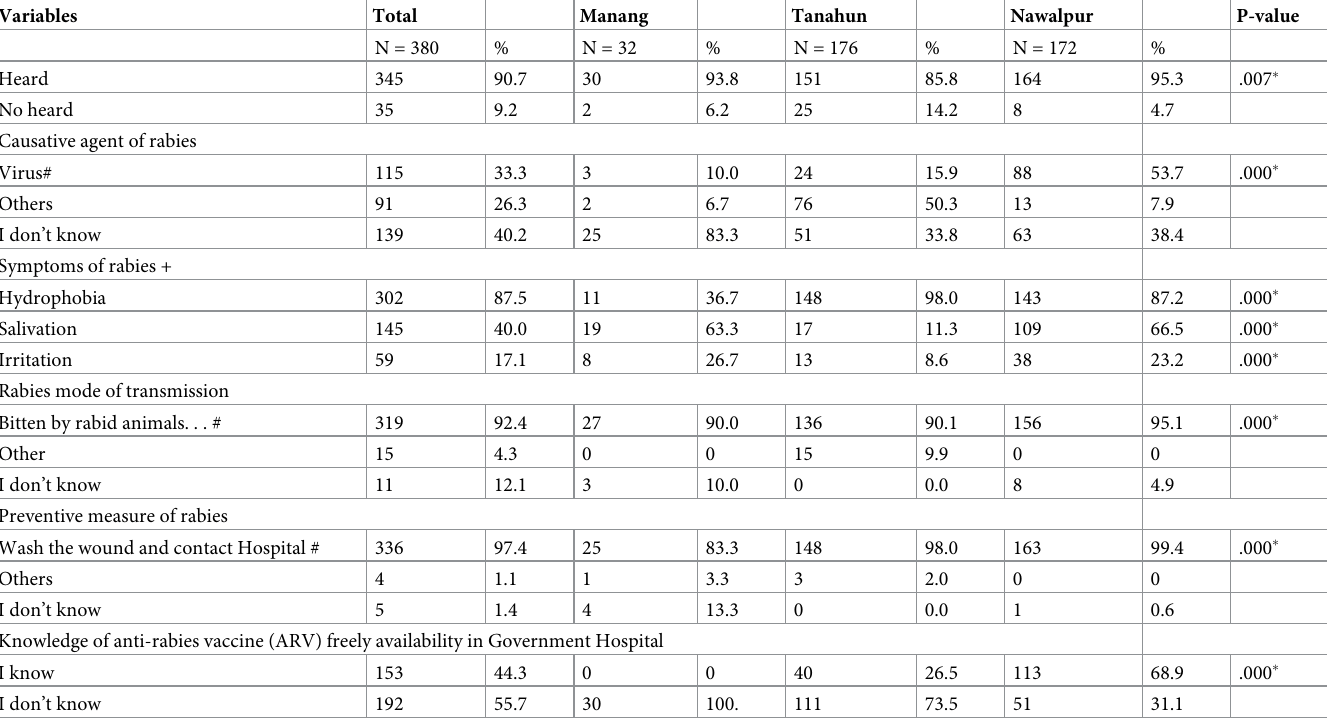
Table 2. Rabies; knowledge-based on ecological regions of the